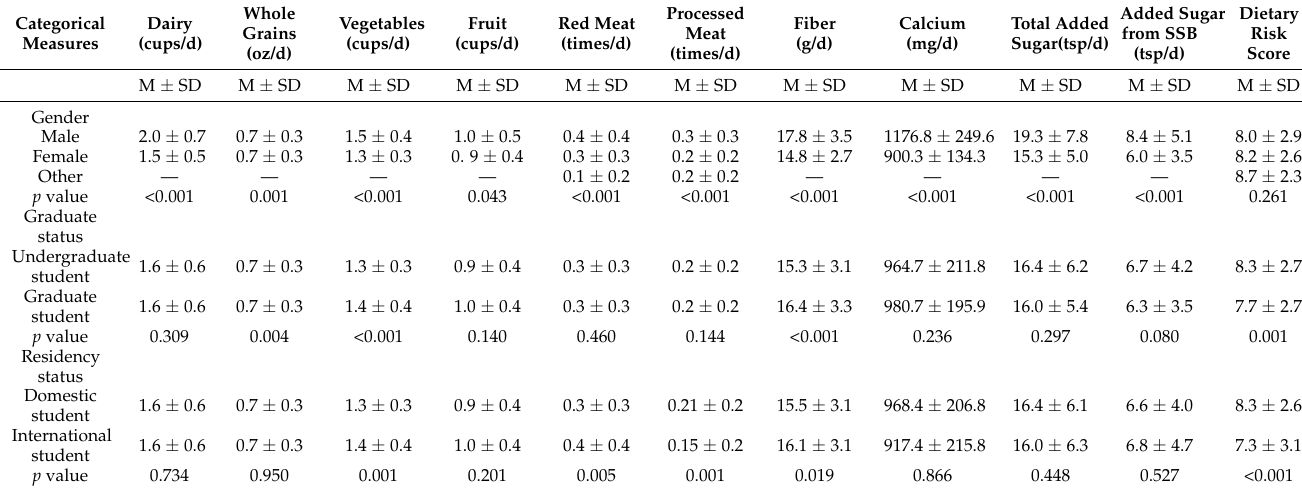
Table 4. Dietary intake, dietary risk score, and their associations with demographic and health characteristics of U.S. higher education students (categorical